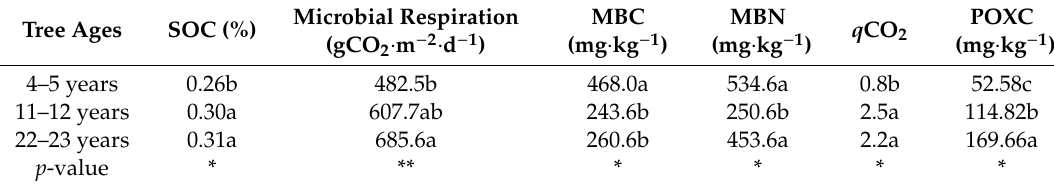
Table 1. Soil properties (0–15 cm) of di ff erently aged rubber tree plantations. Tree Ages